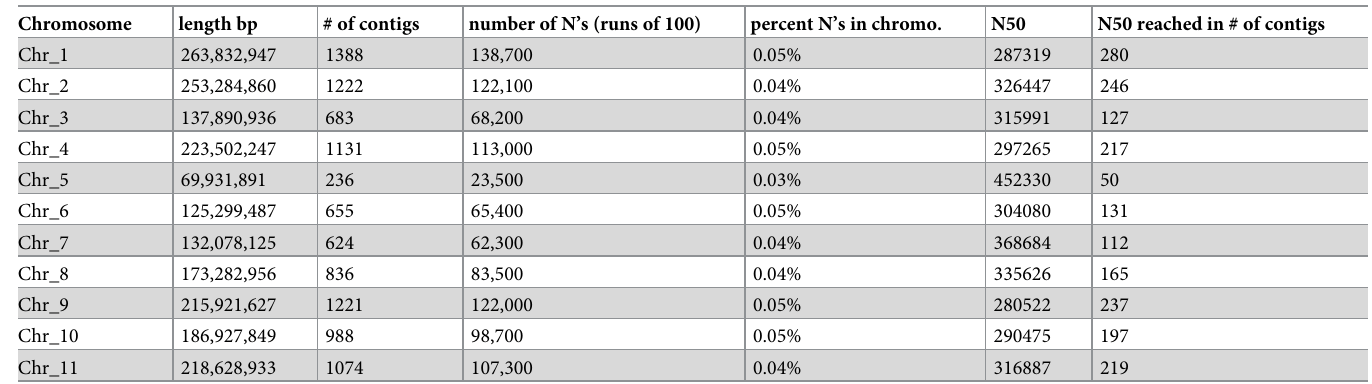
Table 2. Summary statistics for final assembly by